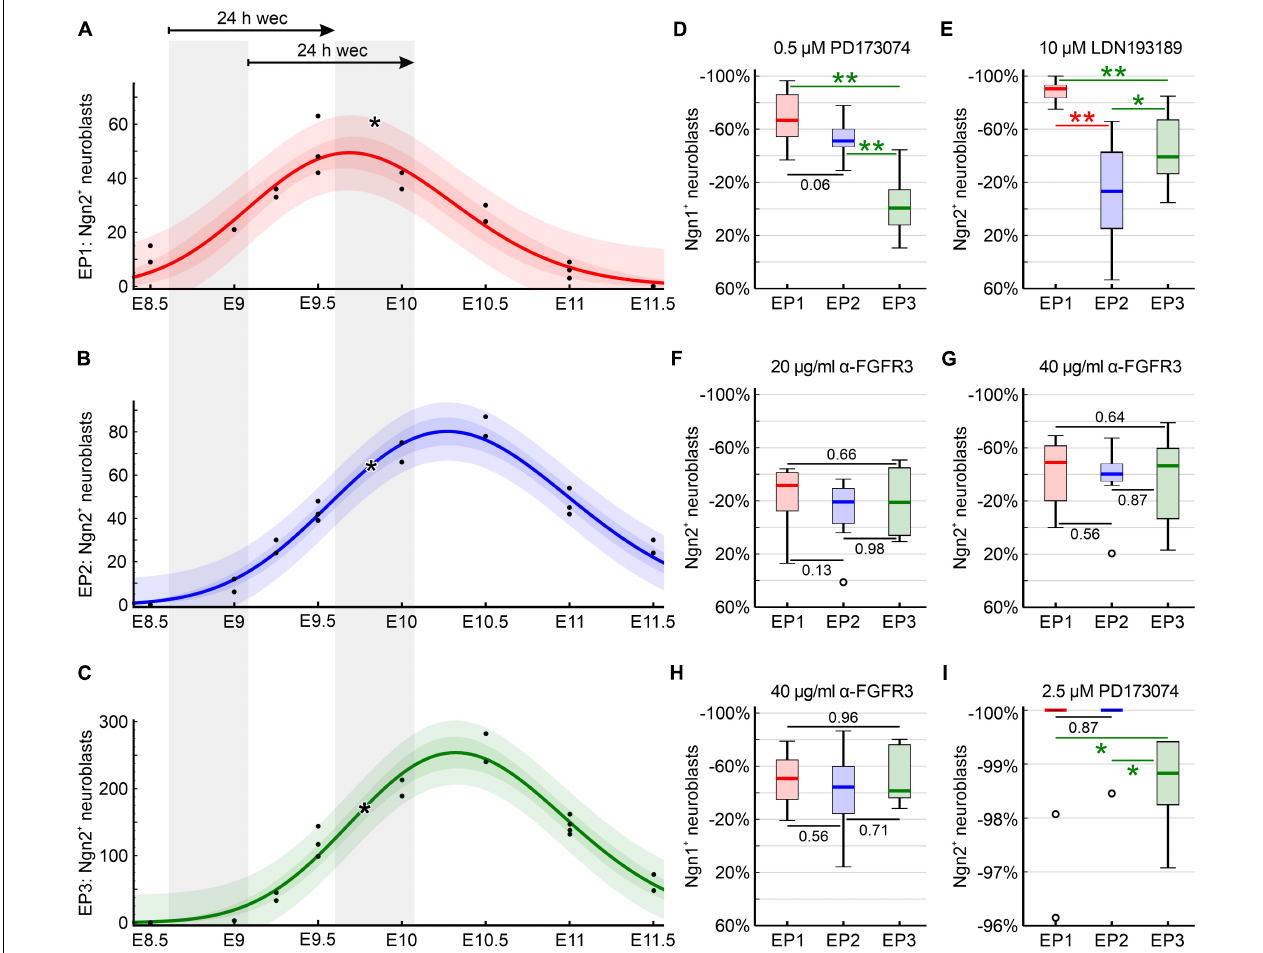
FIGURE 8 | Developmental profiles of the epibranchial placodes of C57BL/6N mice (embryonic days (E) 8.5 to E11.5) as reflected by earlier reconstructions of Ngn2 + intraplacodal neuroblasts (Washausen and Knabe, 2013) recounted for present purposes ( n = 11 mouse embryos with 22 body sides). (A–C) Using CurveExpert Professional (Hyams Development, Chattanooga, TN, United States), regression curves were generated that represent the developmental profiles of the epibranchial placodes 1, 2, and 3 (EP1, red; EP2, blue; EP3, green). Confidence bands (medium red, blue, or green) most likely contain 95% of all values (black dots). Prediction bands (faint red, blue, or green) indicate the range in which 95% of all future values will fall. Here, embryos possessing 9–14 pairs of somites were included in our whole embryo cultures (WECs). This range is indicated by the left of the two gray columns and is correlated with the embryonic age plotted on the x -axis. The right gray column marks the period within which embryos were removed from the culture after 24 h. Asterisks indicate the respective medians of Ngn2 + neuroblasts for EP1, EP2, and EP3 of DMSO control embryos ( Table 2 ). (D–I) Box plots display the relative changes in the numbers of Ngn2 + (E–G,I) or Ngn1 + (D,H) neuroblasts following exposure to either the pan-FGFR inhibitor PD173074 (D,I) , to anti-FGFR3 neutralizing antibodies (F–H) , or to the pan-BMPR inhibitor LDN193189 (E) , respectively (see Table 2 , also for n values). Significant differences between EP1 (red), EP2 (blue), and/or EP3 (green) are indicated by asterisks (* P < 0.05, ** P < 0.001; Mann–Whitney test). Whiskers, lower and upper extremes; box limits, 25th and 75th percentiles; red, blue, or green center lines, medians; open circles, outliers. (D,E) Plausibility checks demonstrate that EP2 and EP3, which almost synchronously produce neuroblasts, by no means always react in